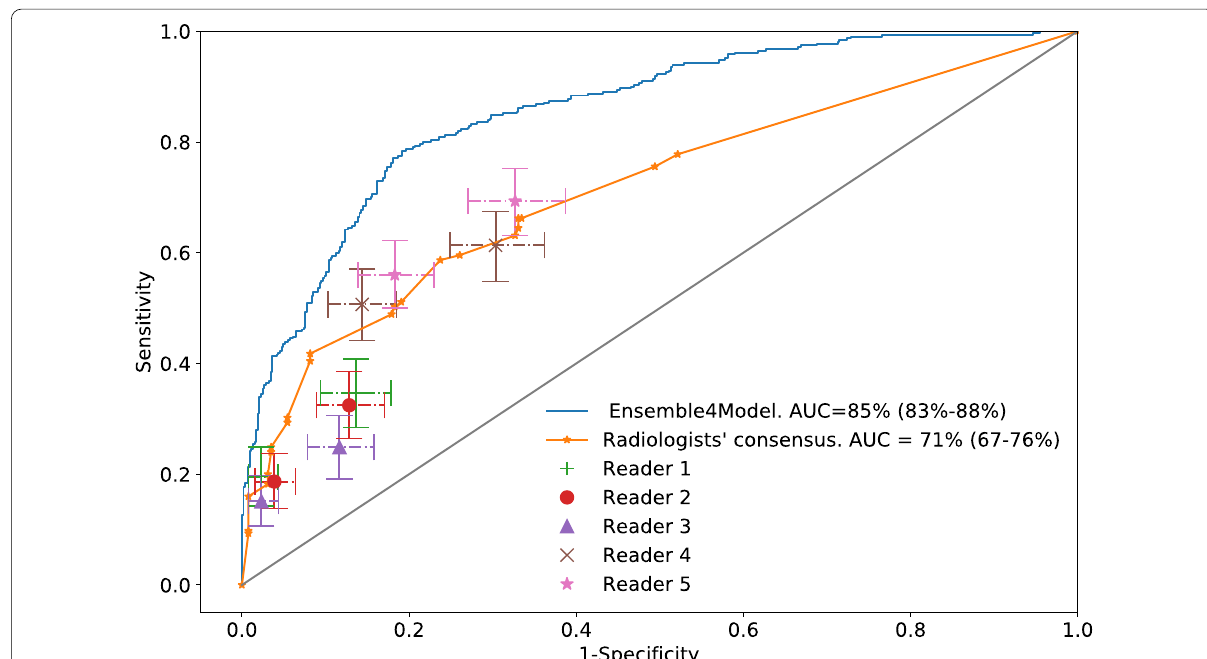
Fig. 4 Sensitivity and specificity for each radiologist with 95% confidence intervals with the ROC curves for the Ensemble4Model (with 95% confidence bands) and the five radiologists’ consensus. Each reader shows two operating points depending on the threshold over the